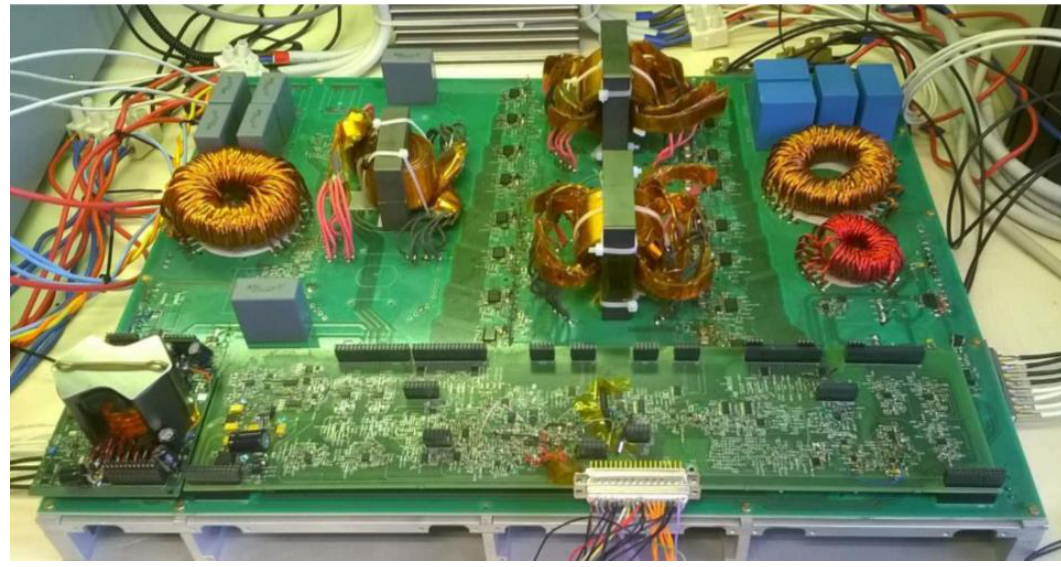
Figure 11. The prototype of the bidirectional FBC, as built and mounted.